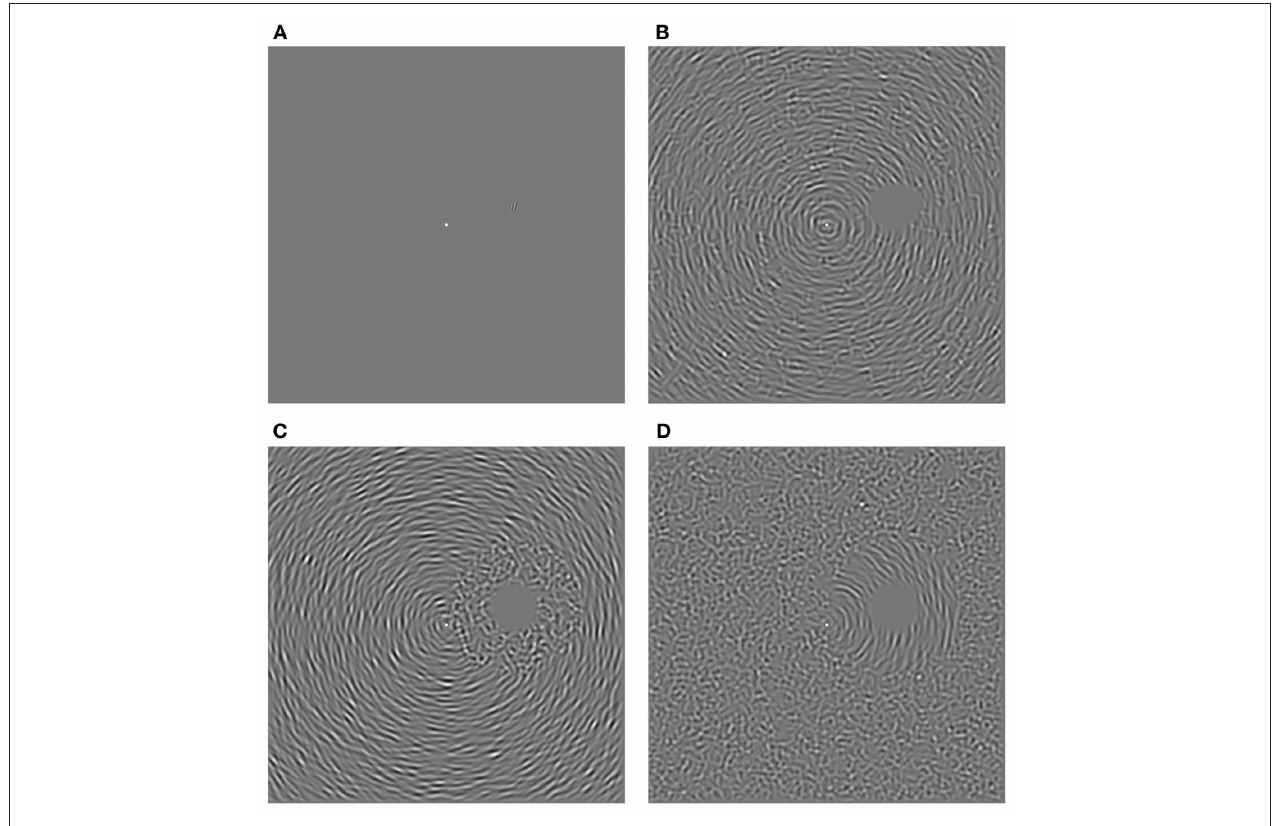
FIGURE 1 | Measuring the spatial specificity of the remote TAE. (A) Exampleof atest stimulus,orientedclockwise of vertical andpositionedabove and to the right of the fixation dot. (B) Noisy concentric adapting stimulus comprising signal and noise elements randomly distributed throughout the